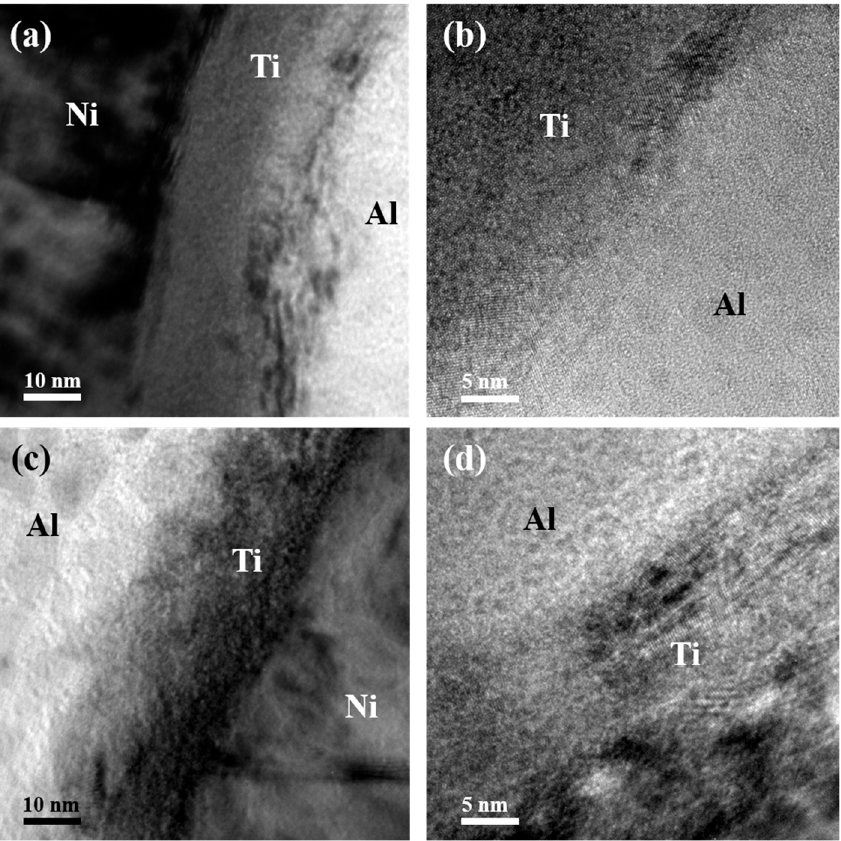
Figure 5. TEM images of the interfaces for the ATNT foil after annealing at 573 K for 3 h: ( a , b ) the Ni/Ti/Al interface; ( c , d ) Al/Ti/Ni interface.